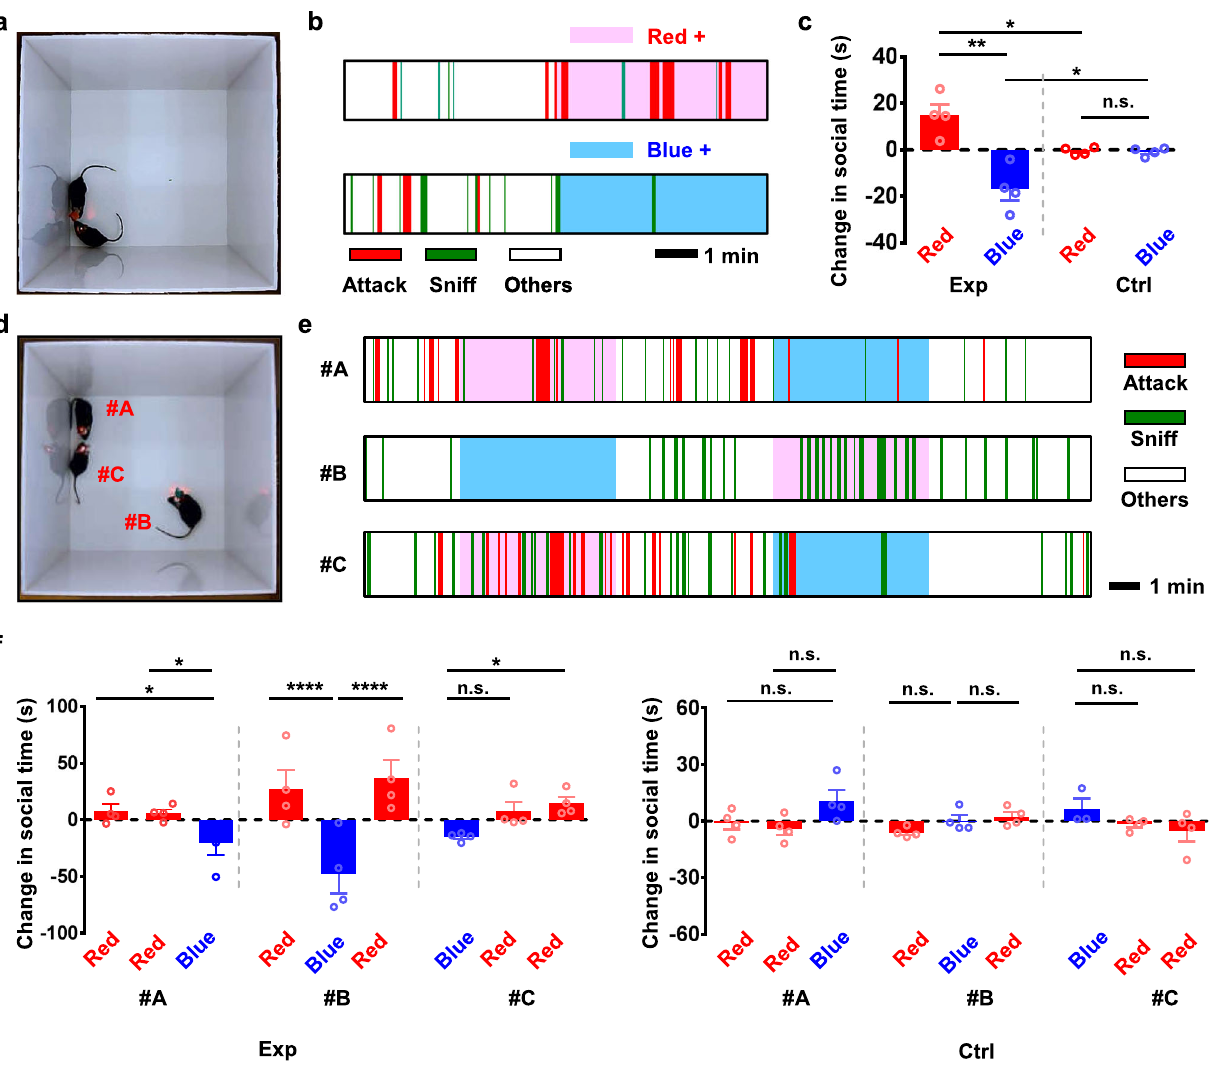
Fig. 4 Bidirectional, in vivo optogenetic control of mice social interactions with wirelessly operated, dual-color micro-LED probes. a Photograph of two DAT-cre mice with wireless probes in an arena (30 × 30 cm 2 ). Experiment groups (Exp) express stGtACR2 + ChrimsonR, and control groups (Ctrl) express EGFP + mCherry. b Representative behavioral sequences recorded for one mouse receiving red or blue stimulations during social interactions. Here snif fi ng and attacking behaviors are highlighted and labeled, and other behaviors include locomotion, resting and escaping. c Summary of changes in social interactions under red or blue stimulations. Here, we compare the time spent in sniff and attack during the 5 min light stimulation with the 5 min resting state. n = 4 groups for both Exp. and Ctrl. Two-way ANOVA, Sidak ’ s multiple-comparisons test (experiment versus control). d Photograph of three DAT- cre mice with wireless probes in an arena. e Representative behavioral sequences recorded for the three mice (#A, #B, #C) receiving red or blue stimulation during social interactions. f Summary of changes in social interactions under red or blue stimulations for each mouse. n = 4 groups for both Exp (left) and Ctrl (right). Two-way ANOVA, uncorrected Fisher ’ s LSD (red versus blue). * P < 0.05, ** P < 0.01, *** P < 0.001, **** P < 0.0001, n.s. P > 0.05. All data are represented as mean ± s.e.m. See Supplementary Table 1 for detailed statistical analysis. Source data are provided as a Source Data fi